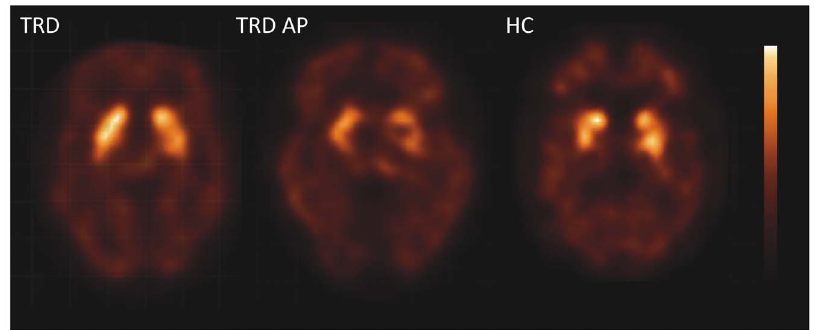
Figure 1. Transversal images of D2/3R availability. Transversal [123I]IBZM SPECT slices at the level of the striatum showing D2/3 receptor availability in a TRD patient, a TRD patient on antipsychotics (TRD AP), and a healthy control subject.